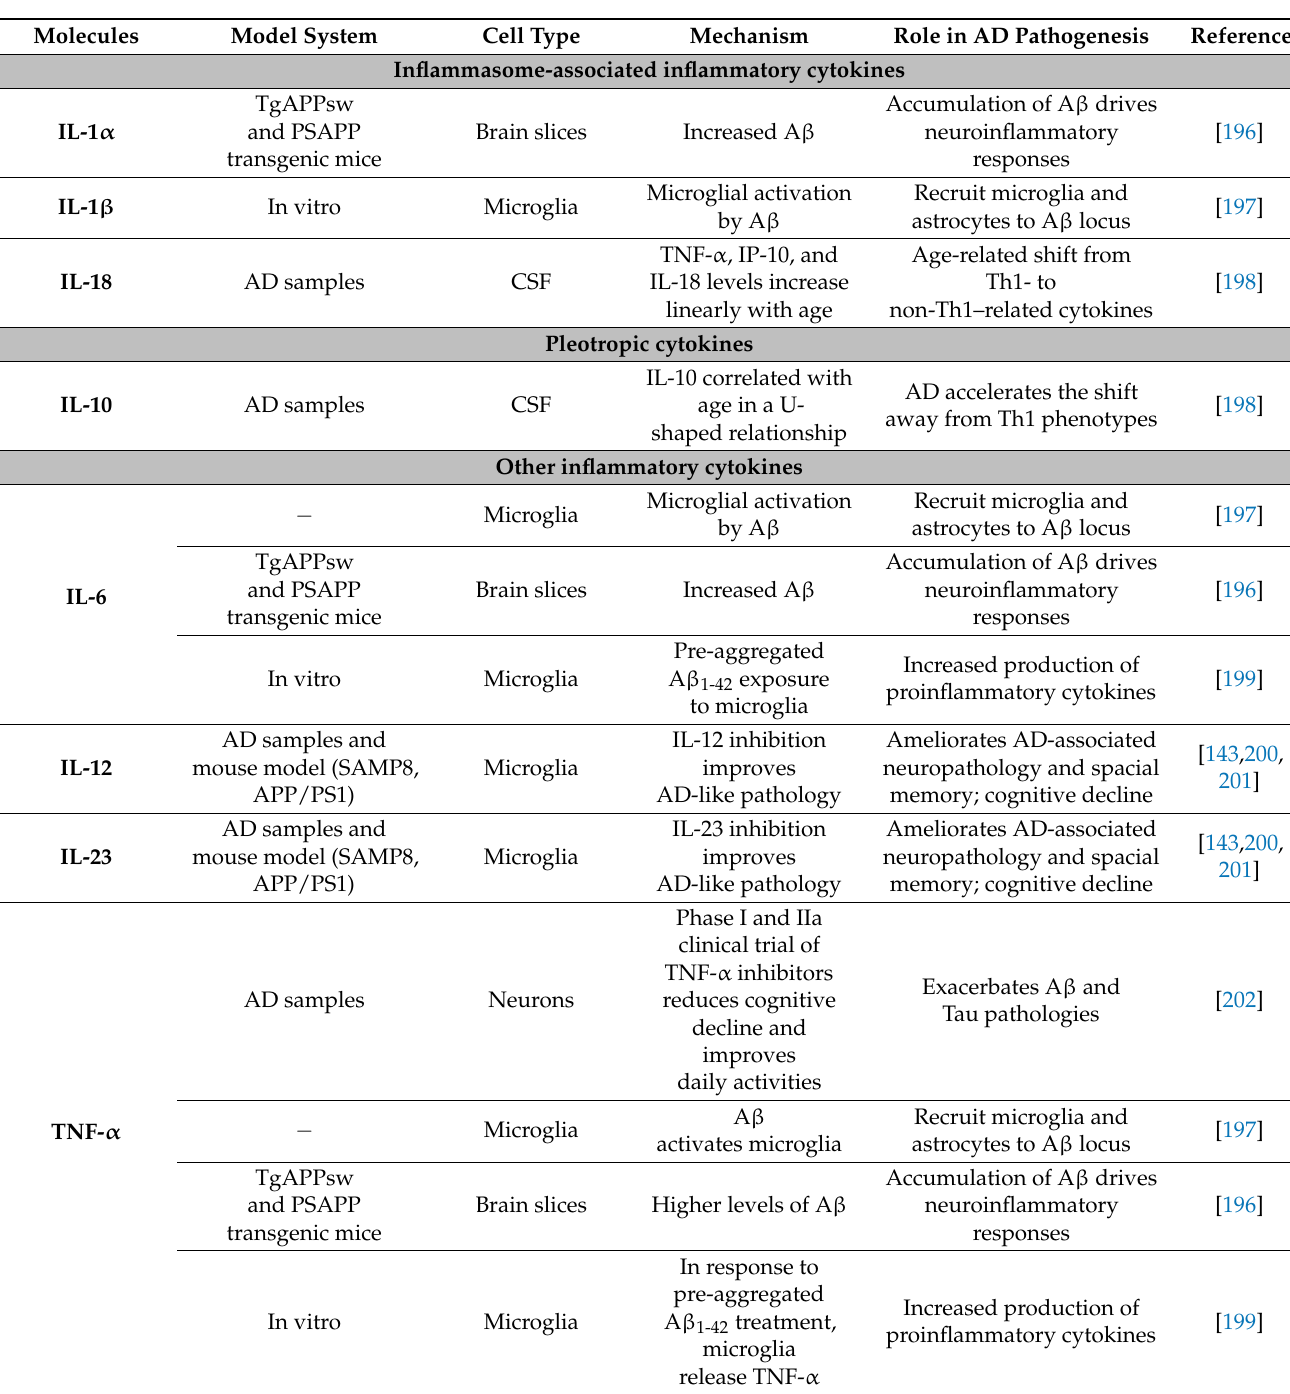
Table 4. Cytokines and interferons involved in Alzheimer’s